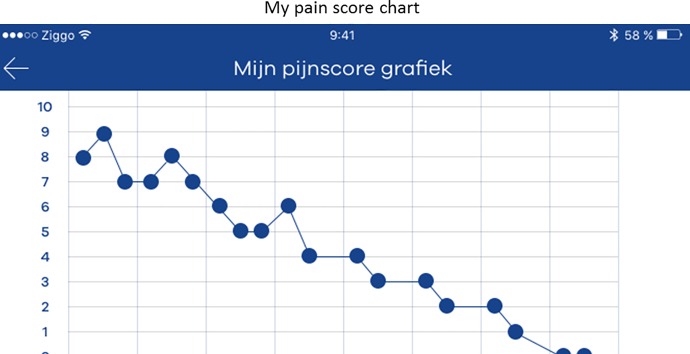
In-app pain chart.